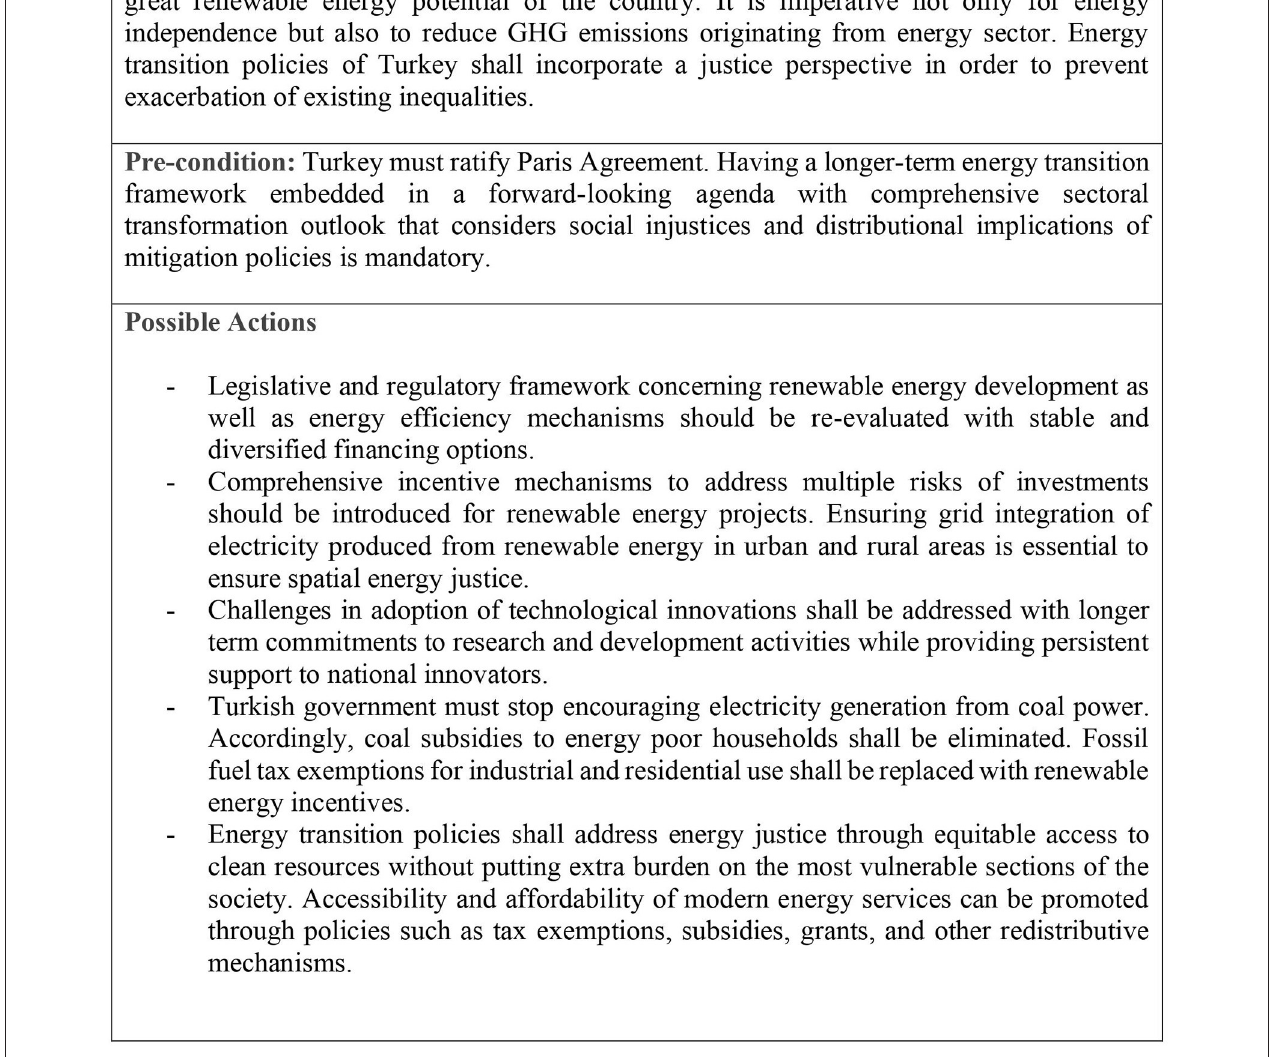
FIGURE 2 | Actionable Policy Recommendations for Renewable Energy Transition in Turkey. among the most important parameters for sustainable transition of mobility systems in Turkey. Policy measures that include mandatory CO 2 standards, CO 2 based vehicle taxation and improved CO 2 labeling schemes 12 that shall 12 Directive 1999/94/EC of the European Parliament and of the Council (1999). Relating to the Availability of Consumer Information on Fuel Economy and CO2